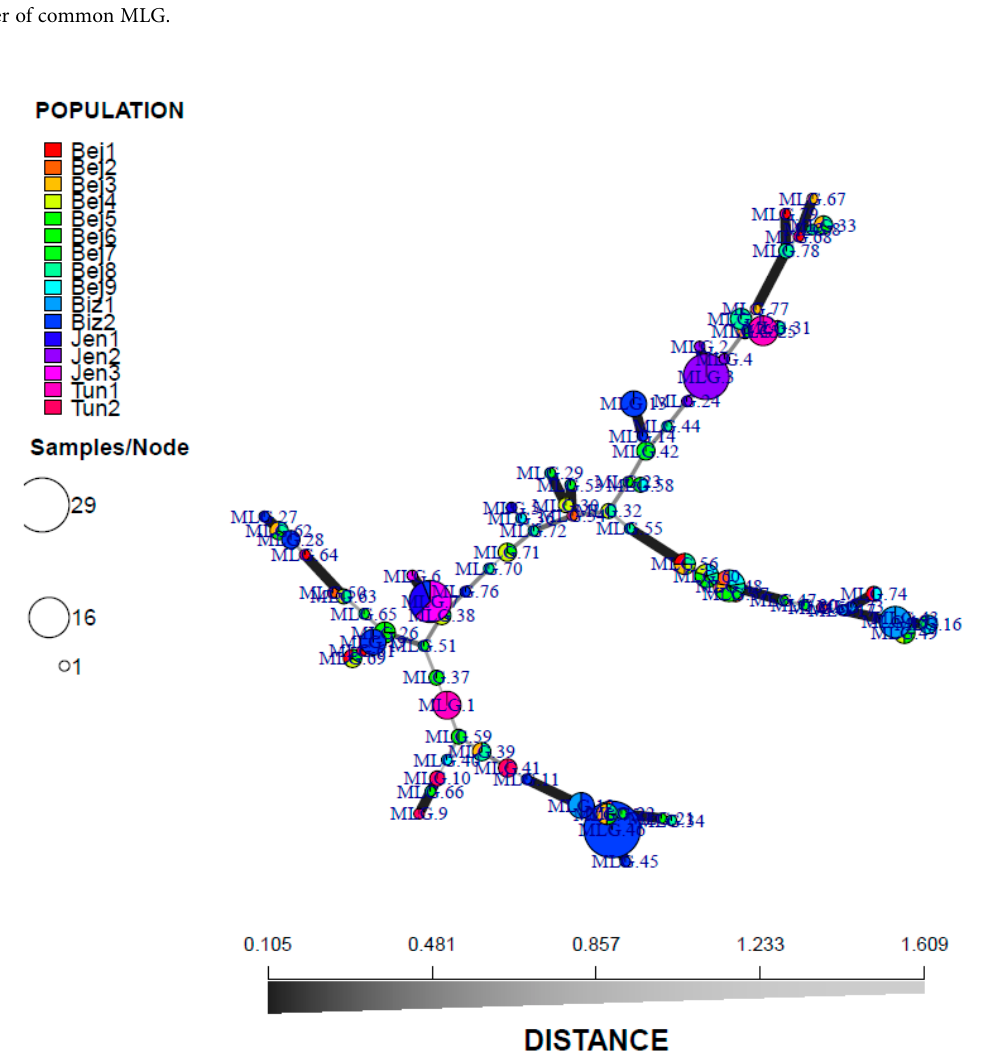
Figure 3. Minimum spanning network (MSN) of 67 haplotypes detected in the Ascochyta fabae collection of 2012. Each circle represents a unique haplotype and the different colours represent the sampling fields. The circle sizes represent the haplotype frequencies and the num- bers of isolates is indicated in circles. Line widths and the shading represent relatedness of the haplotypes, based on Nei’s genetic